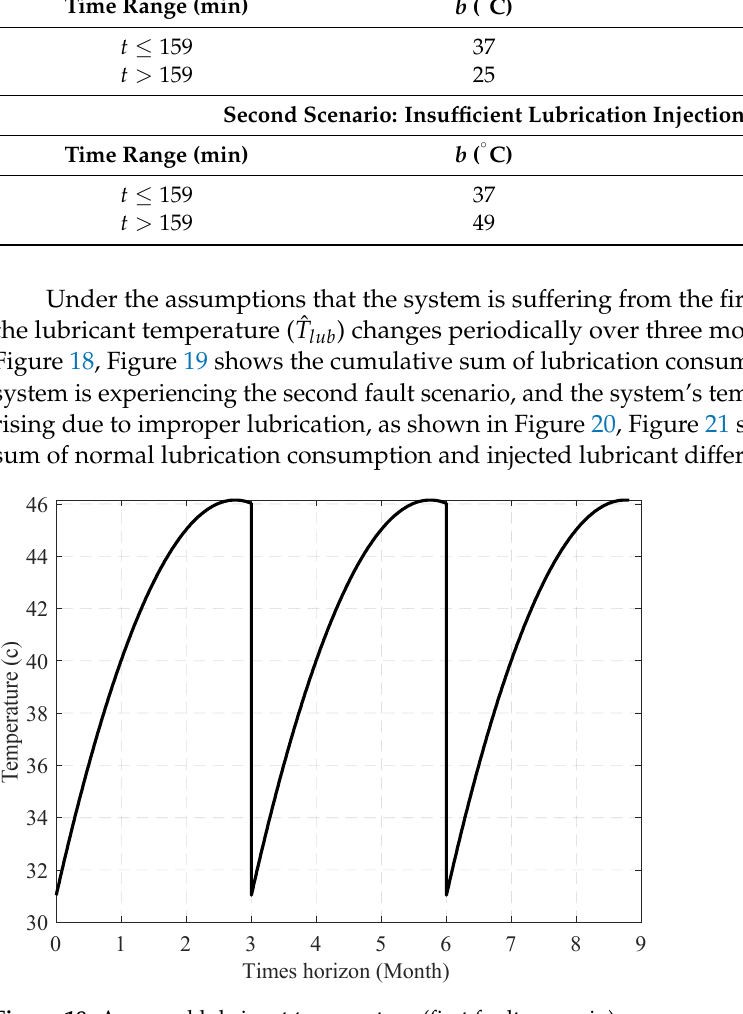
Figure 19. Failure prognosis results (first fault scenario): ( a ) using PF for temperature estimation and the two-step method for parameter estimation; ( b ) using APF for temperature estimation and the two-step method for parameter estimation; and ( c ) using APF for temperature estimation and the one-step method for parameter estimation.